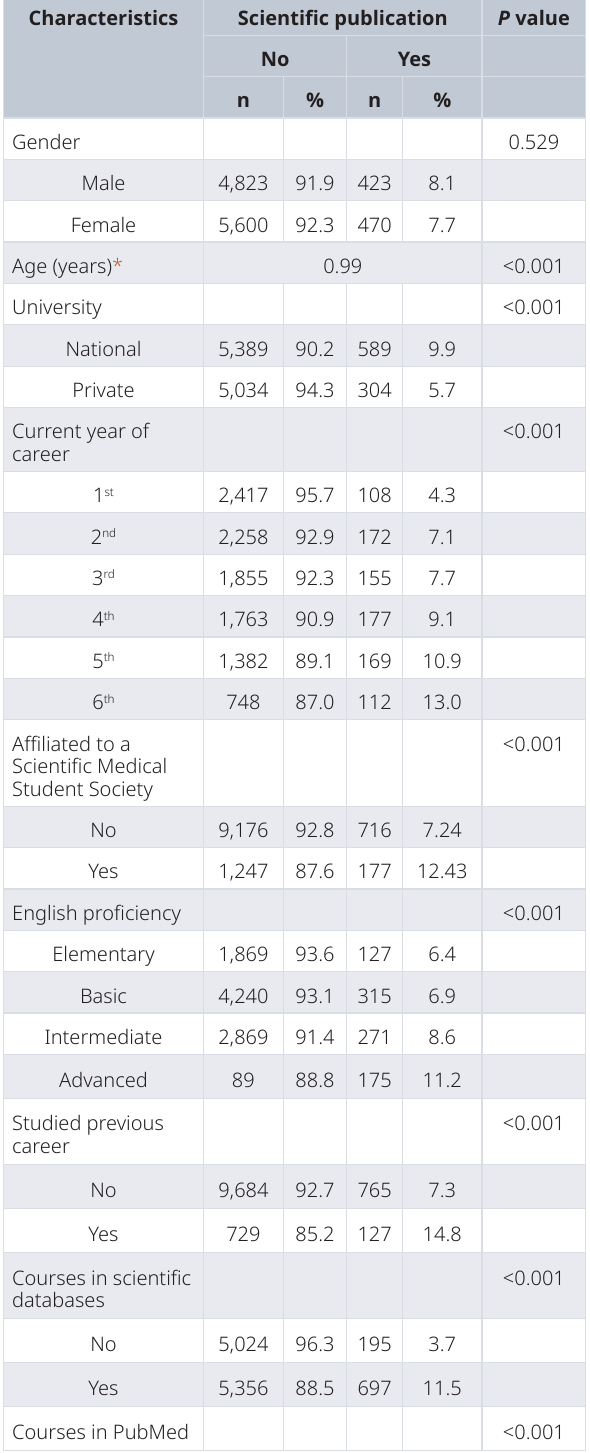
Table 2. Characteristics of medical students among scientific publication from 40 schools of medicine in Latin